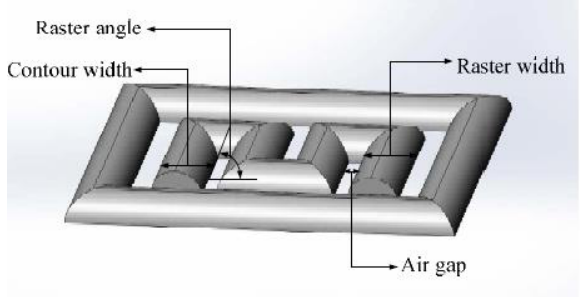
Figure 9. Raster angle, raster width and air gap. Reprinted with permission from [42], 2018, Emerald Publishing, Bingley, UK.